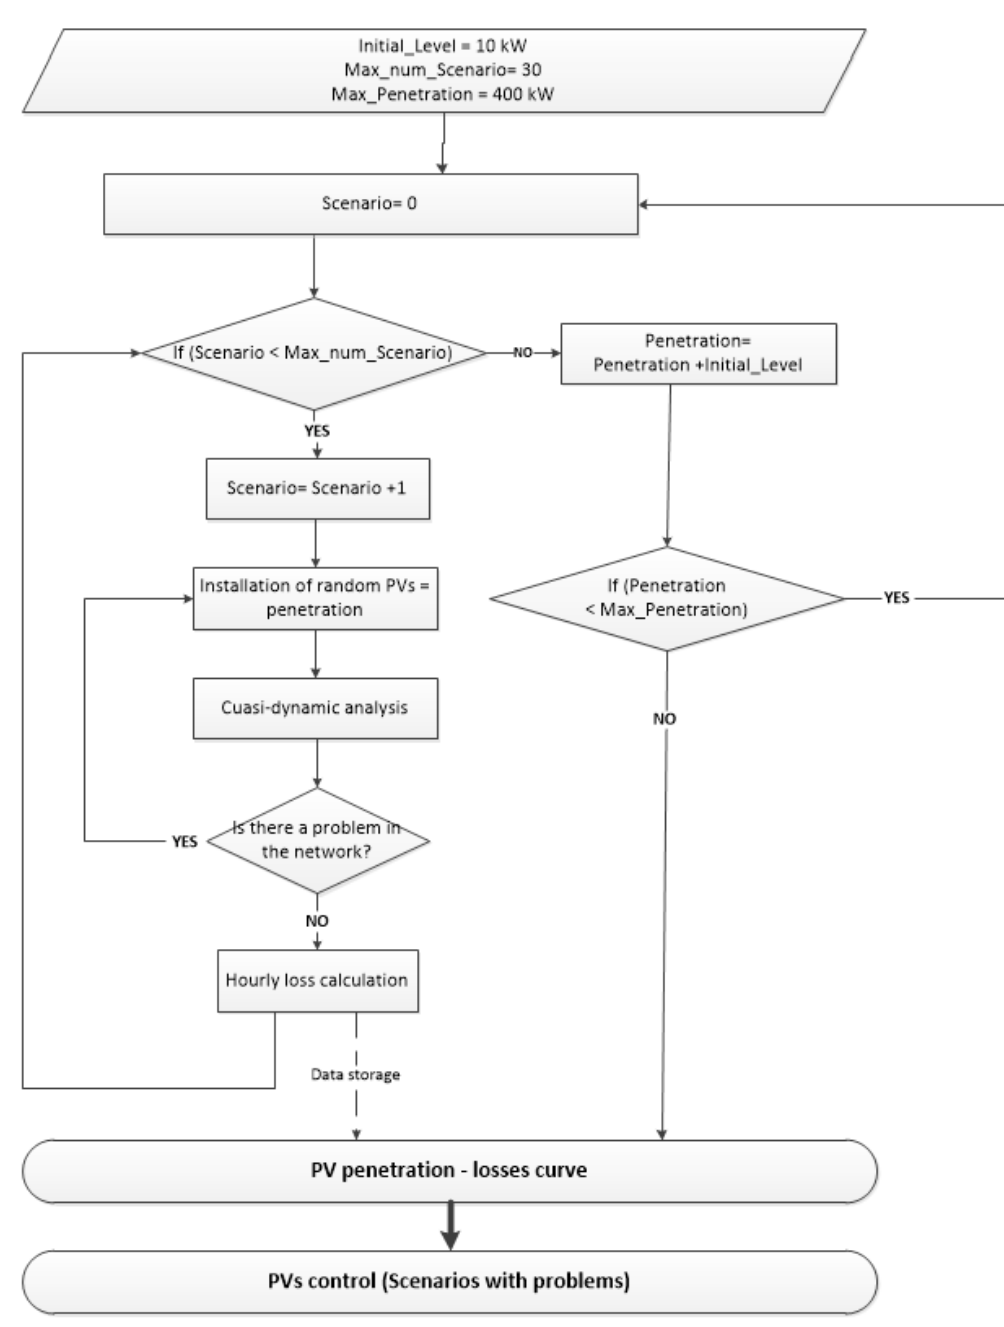
Figure 1 . Methodology to obtain the optimal PV penetration level. Figure 1. Methodology to obtain the optimal PV penetration